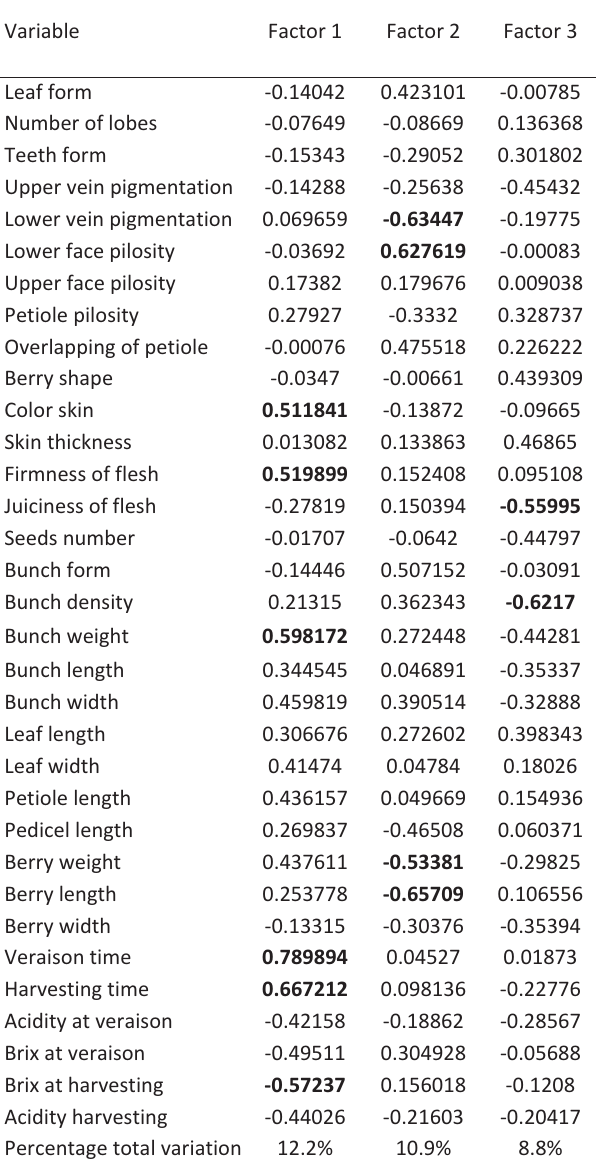
The characters in bold are